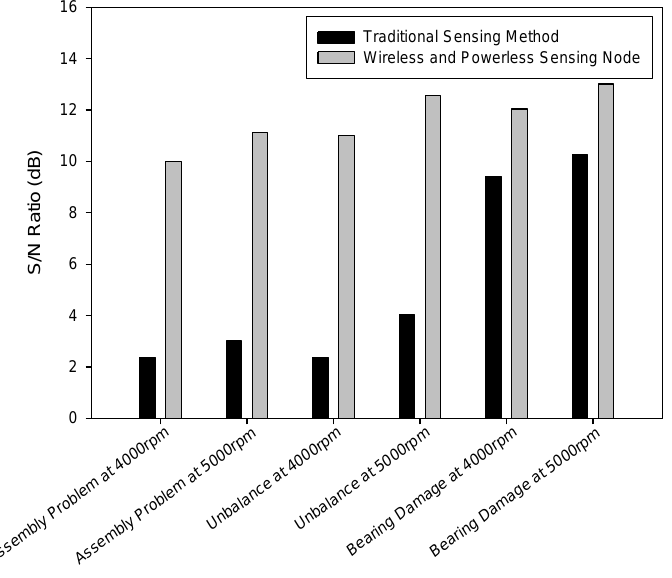
Figure 11. The WPMS possesses higher SNR compared to the traditional diagnosis method.